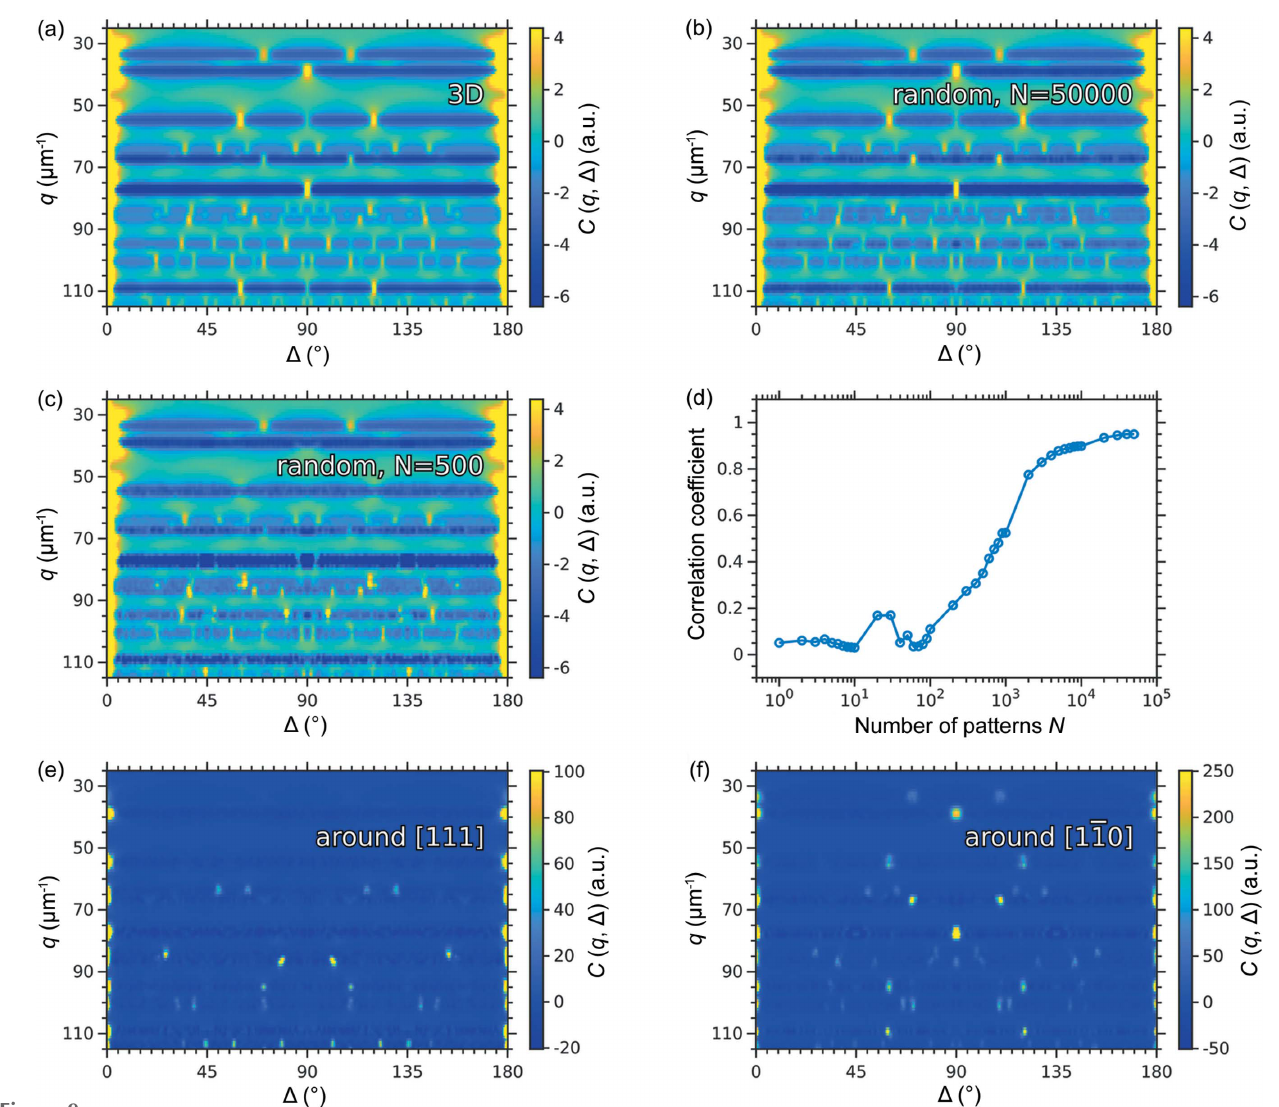
Figure 9 2D correlation maps C ( q , (cid:2) ) calculated for ( a ) the simulated scattered intensities in 3D reciprocal space and ( b )–( e ) 2D diffraction patterns from a randomly oriented sample averaged over ( b ) 5 (cid:7) 10 4 and ( c ) 5 (cid:7) 10 2 patterns. The scattered intensity distribution in 3D reciprocal space and the 2D diffraction patterns were simulated for the same colloidal crystal with an f.c.c. structure. ( d ) Pearson correlation coefficient r ( N ) between the CCF maps averaged over different numbers of 2D diffraction patterns and the CCF map calculated for the intensity distribution in 3D reciprocal space for the same sample. ( e )–( f ) 2D correlation maps C ( q , (cid:2) ) calculated for 2D diffraction patterns obtained by rotation of the sample with an f.c.c. structure around the ( e ) [111] f.c.c. and ( f ) [110] f.c.c.